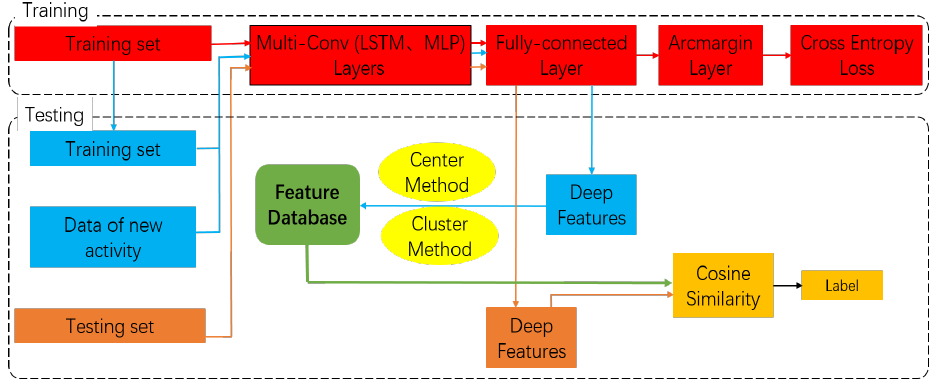
Figure 2. Framework for open-set human activity recognition.